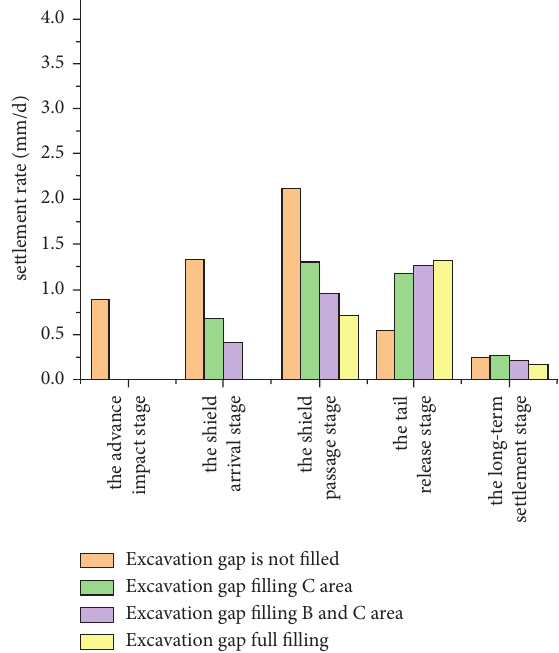
Figure 31: Settling rate at each